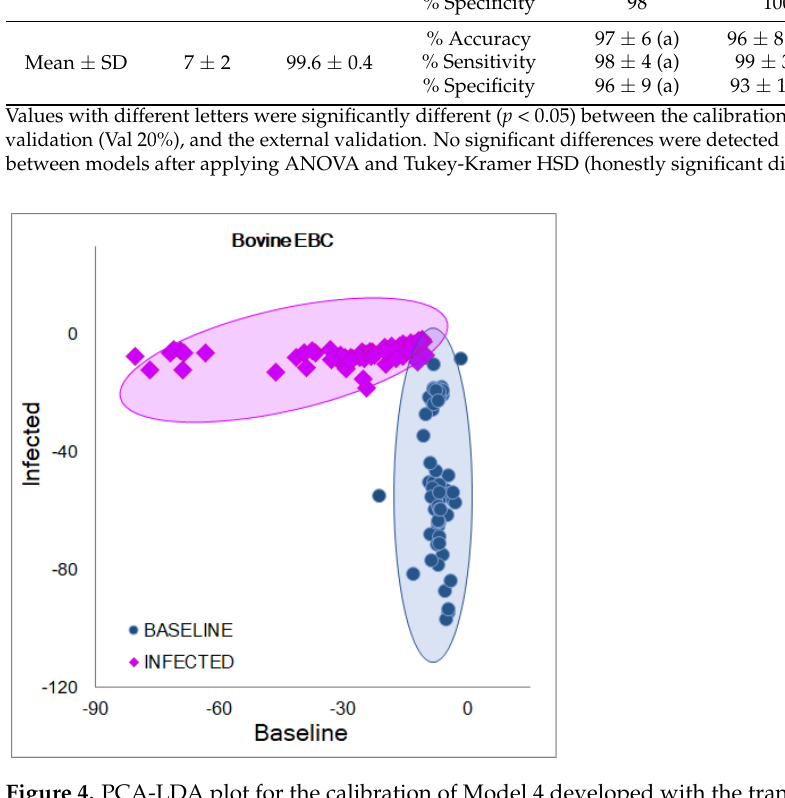
Figure 4. PCA-LDA plot for the calibration of Model 4 developed with the transformed absorbance (1300–1600 nm) from EBC collected before and after the BRSV challenge.